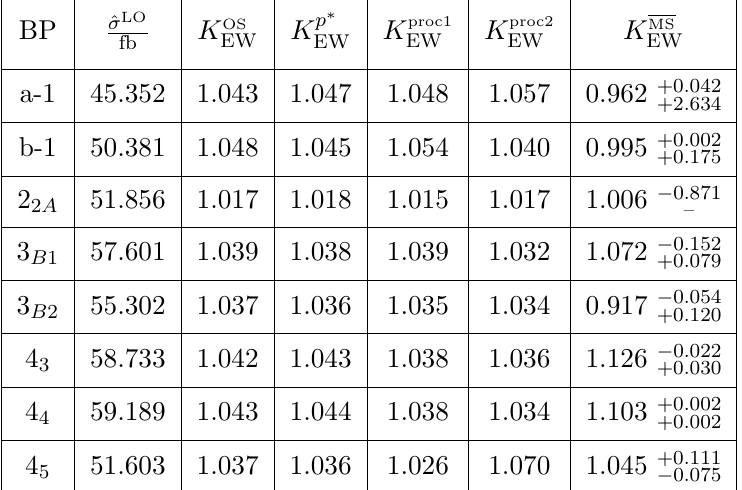
Table 4 . The NLO electroweak K-factors for the process g + g H l for the 2HDM benchmark ! points (BP) that are not in the alignment limit are presented. They are de(cid:12)ned in table 2. The renormalization scale has been set to (cid:22) 0 as de(cid:12)ned in eq. (3.4) for the MS scheme. The lower (upper) value of the MS result corresponds to the change when taking (cid:22) 0 = 2 (2 (cid:22) 0 ) as renormalization scale. The lower MS uncertainty for BP 2 2 A is not shown, since the RGEs (3.5) do not allow for a stable solution, see also (cid:12)gure 9 of appendix B.